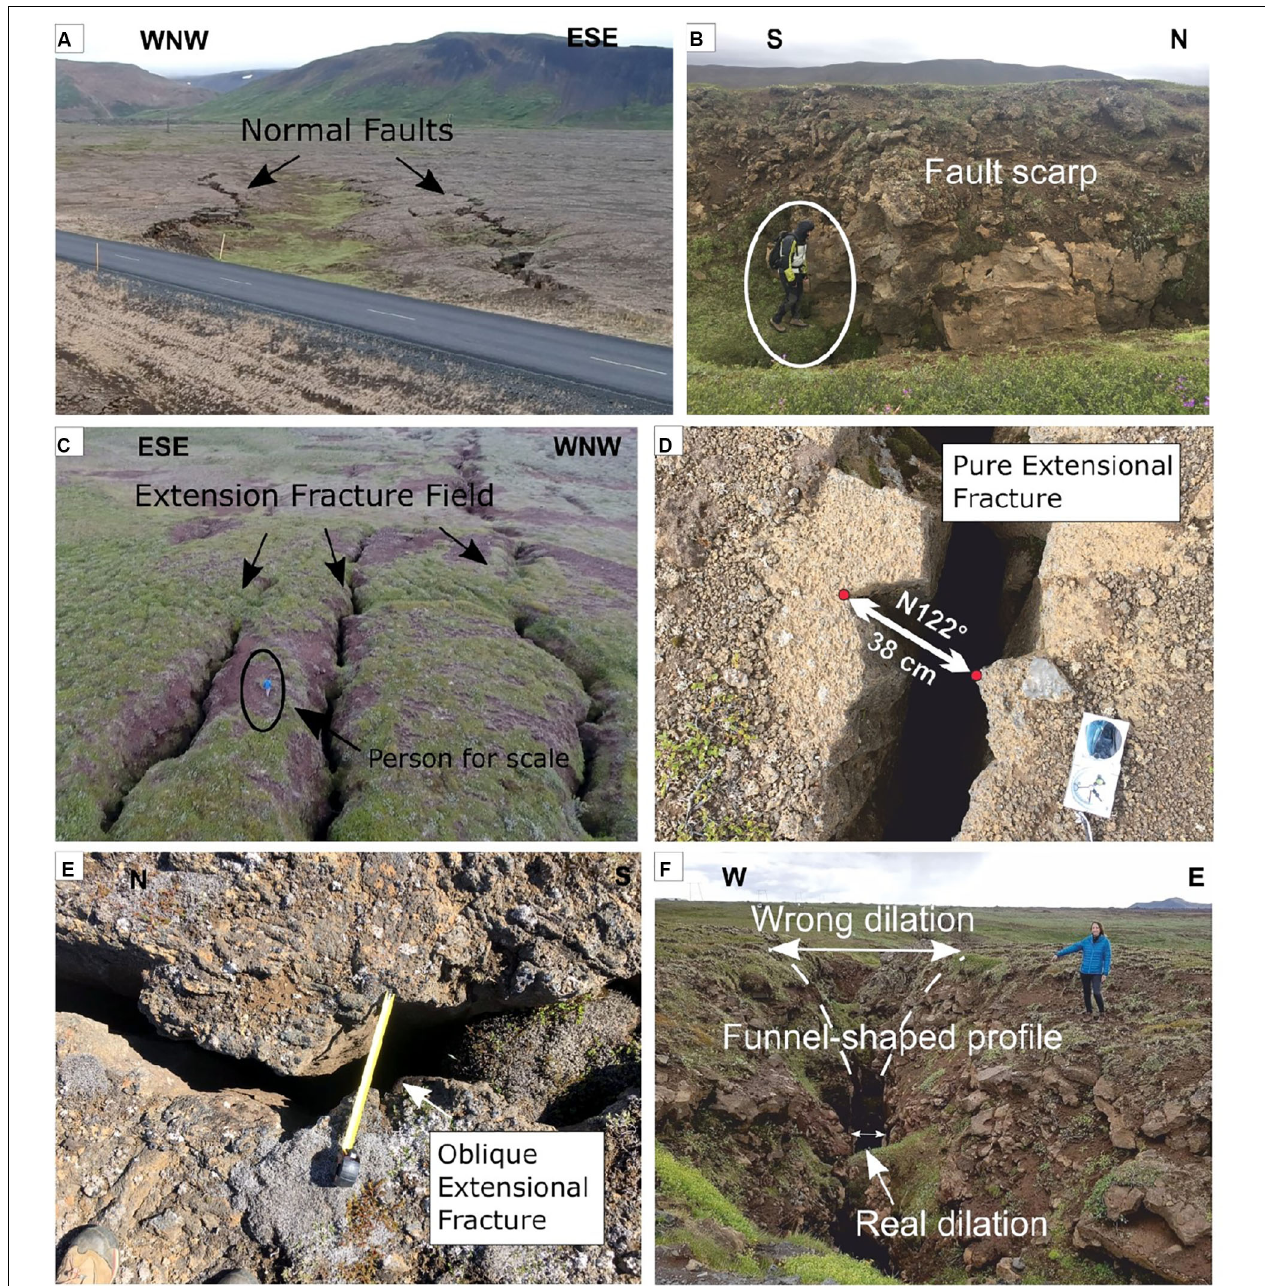
FIGURE 3 | Examples of structures studied in the field. (A) Graben structures, with the two opposite-dipping normal faults. (B) Normal fault, person for scale. (C) UAV-captured picture of an extension fracture field, person for scale. (D) Example of piercing points along pure extension fracture, with indication of opening direction and amount of opening. (E) Example of piercing points along an oblique extension fracture, with a right lateral component. (F) Example of extension fracture with indication of real and wrong dilation, the latter caused by a funnel-shaped profile.